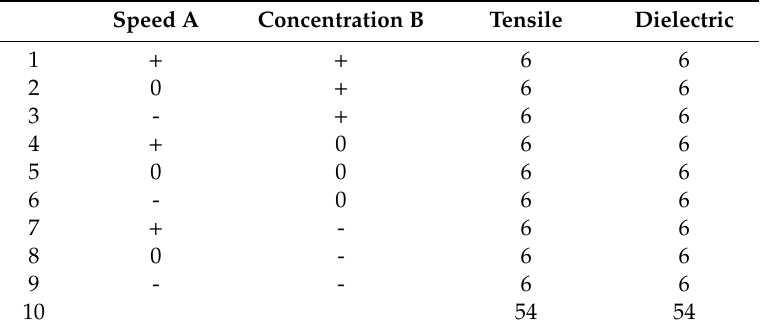
Table 1. Test matrix for the original and improved systems.